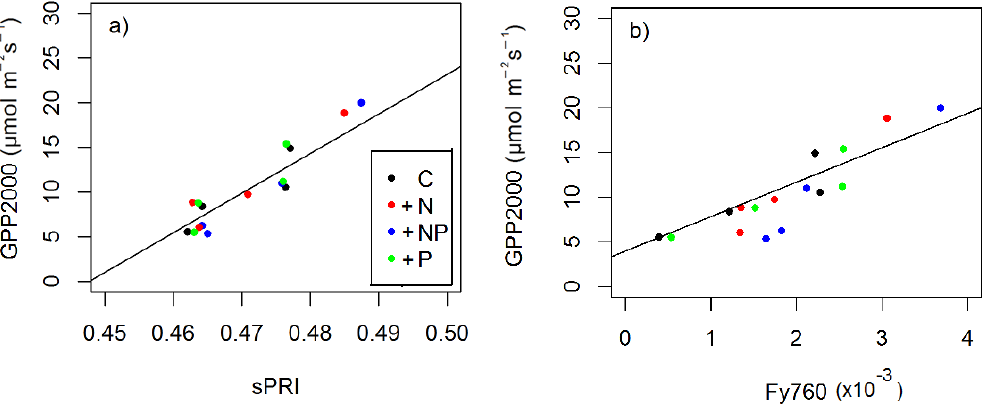
Figure 5. (a) Relationship between GPP2000 and average values of sPRI and (b) apparent fluorescence yield (Fy760). Lines represent results with the best linear regressions fitting the